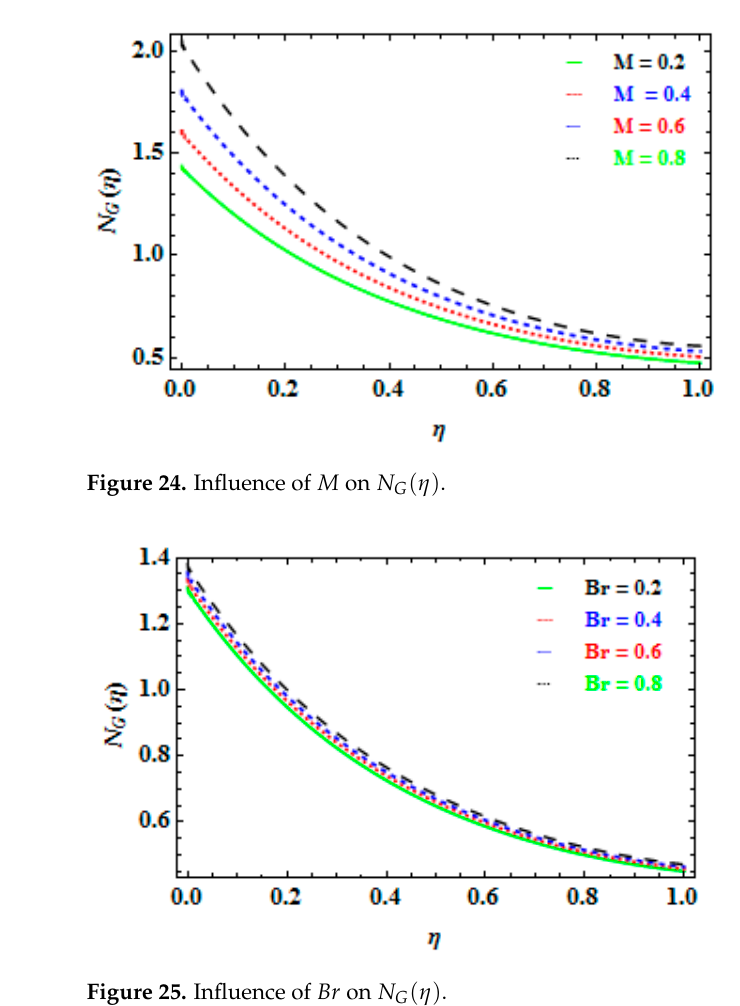
Figure 23. Influence of R e on 𝑁 (cid:3008) ( 𝜂 ).